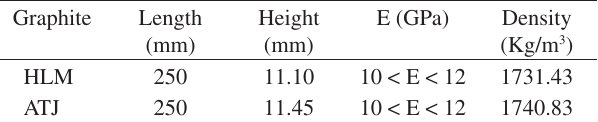
Table 1. Characteristics and Elasticity Modulus of the synthetic graphite beams. Graphite